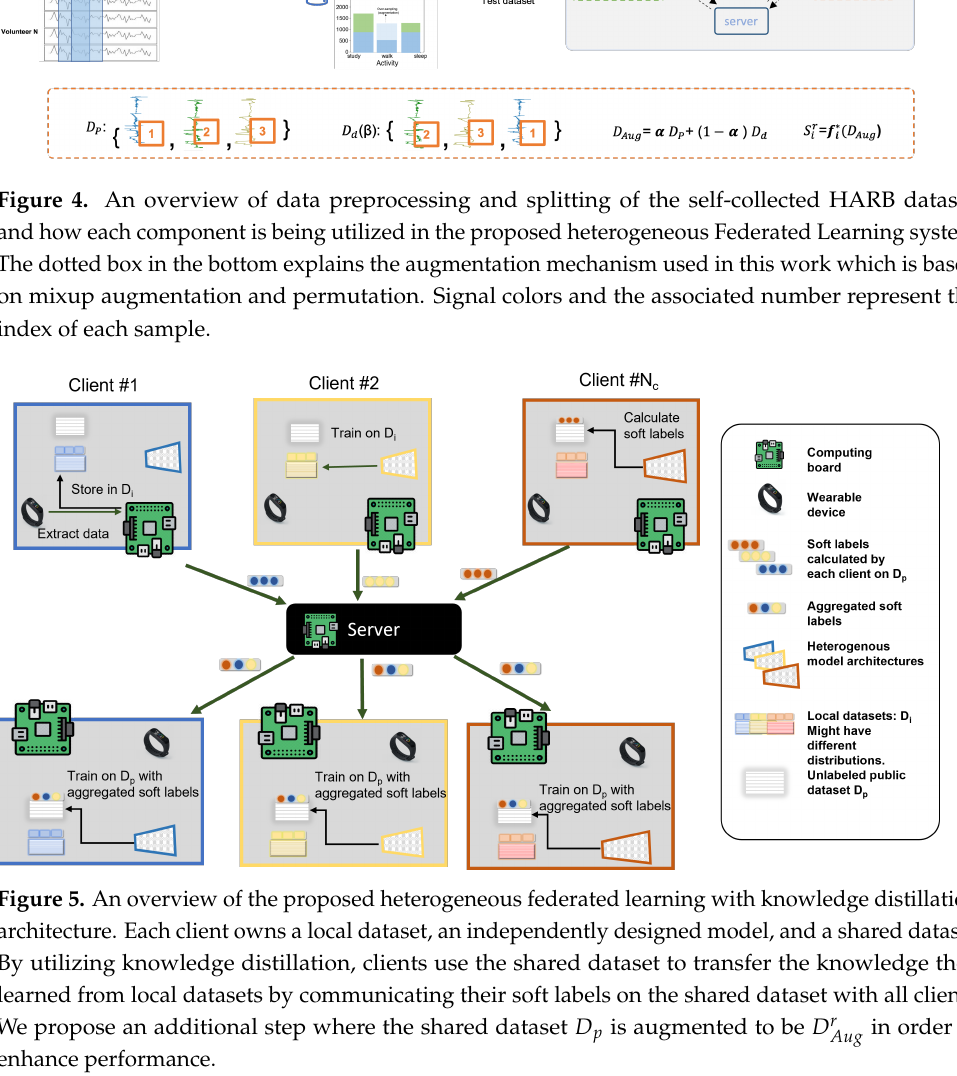
in order to Aug